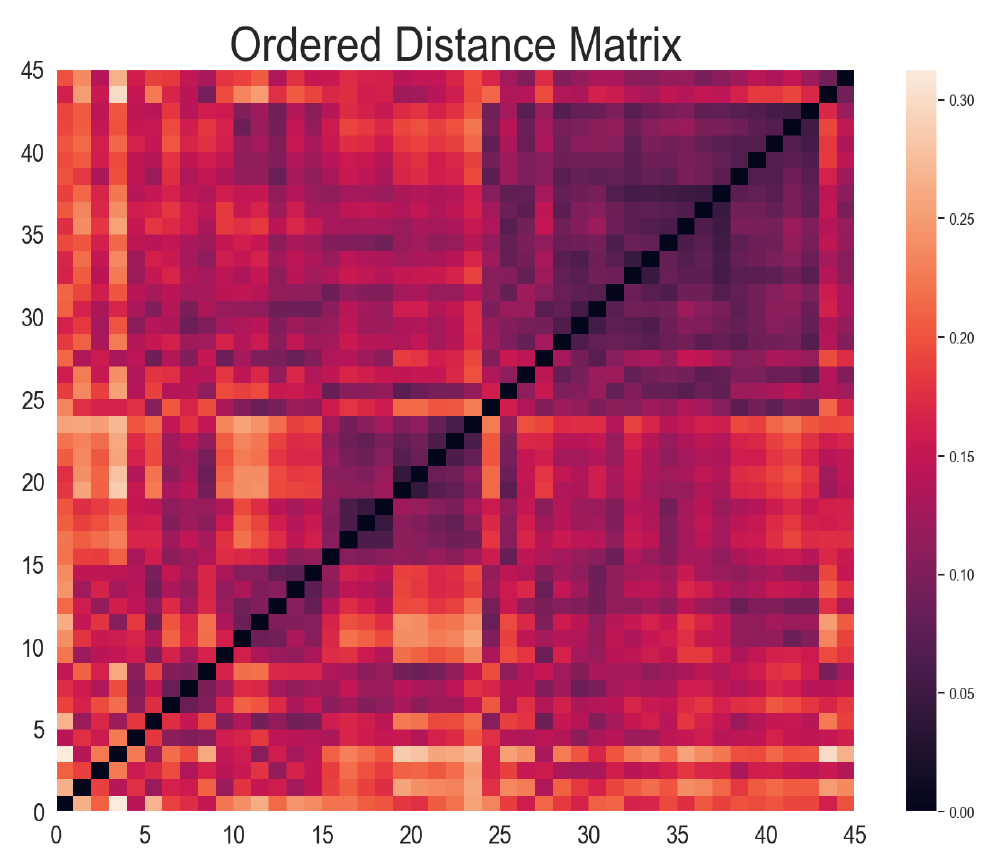
Fig 5. Covariance